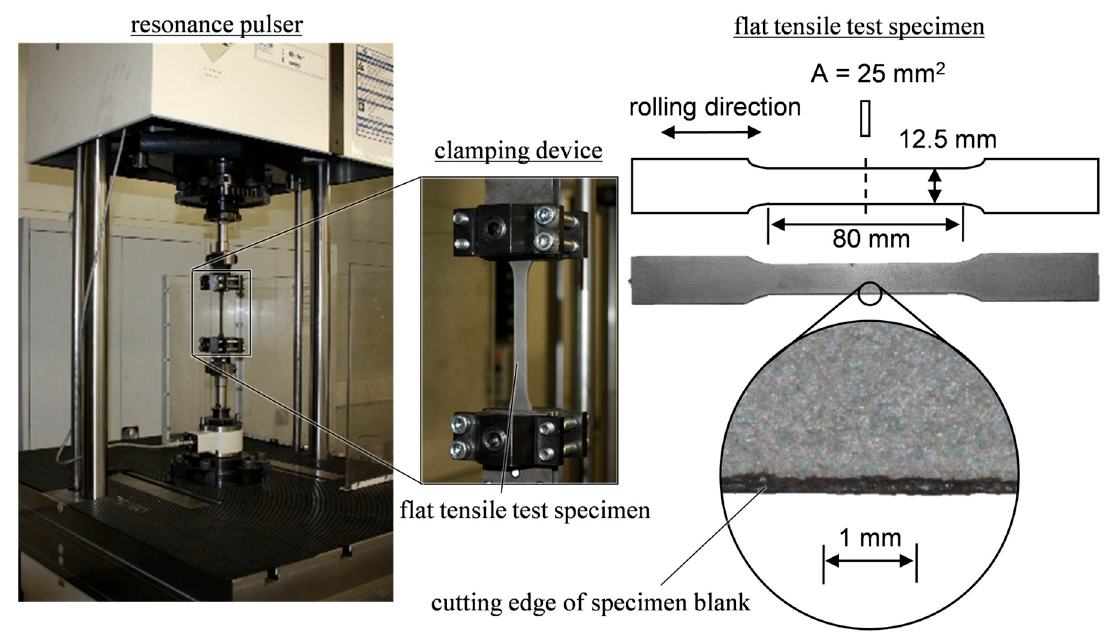
Figure 1. Experimental stand for fatigue tests and sample